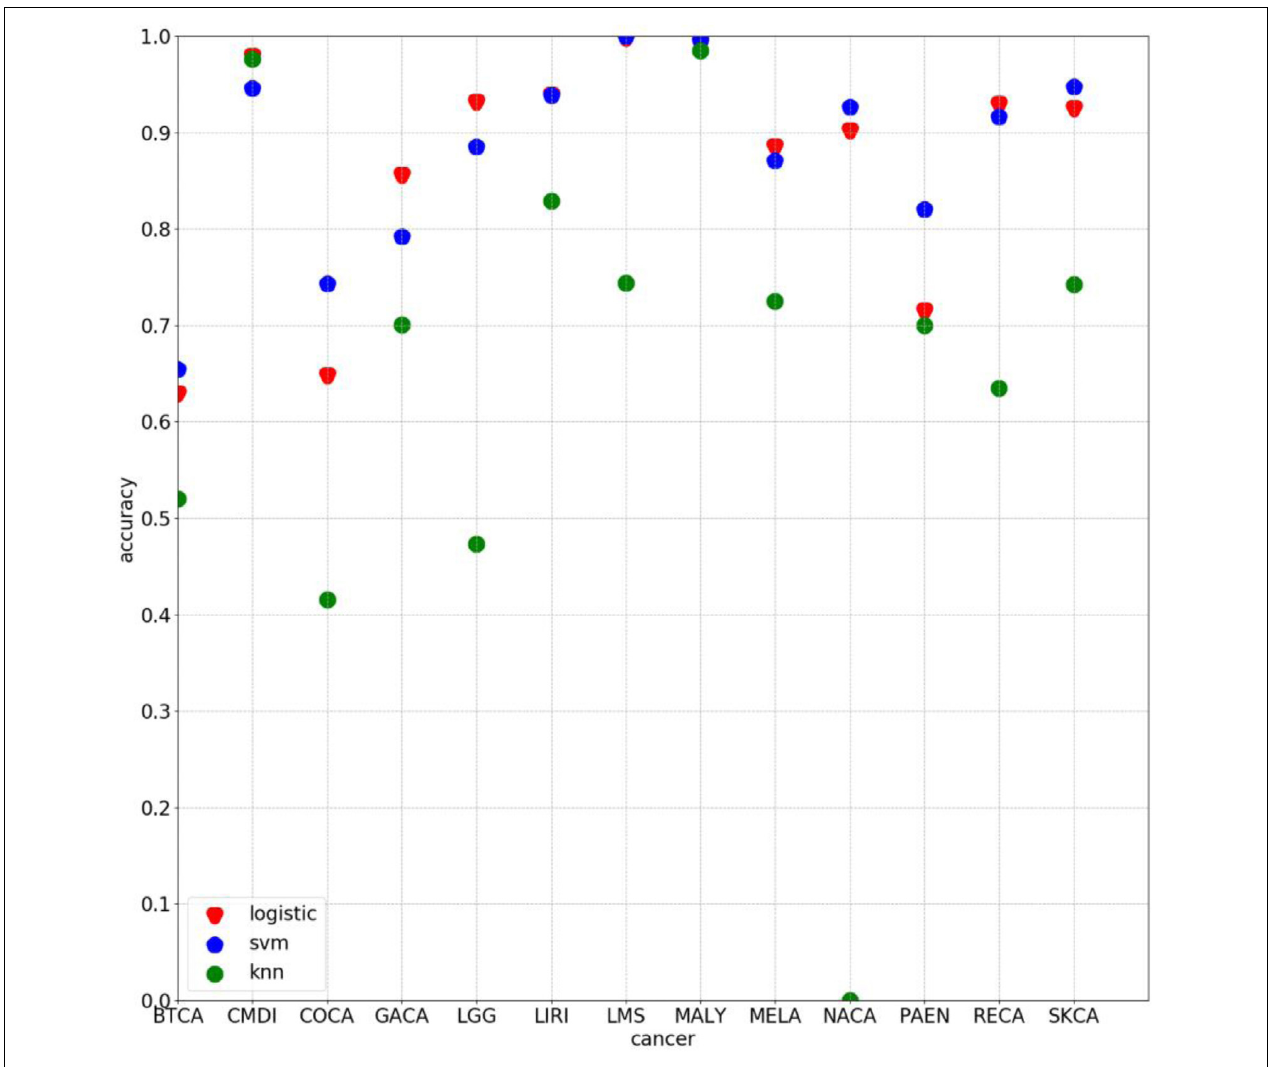
FIGURE 5 | Classification accuracy on each cancer by using 500 chosen genes based on logistic, svm, and knn,